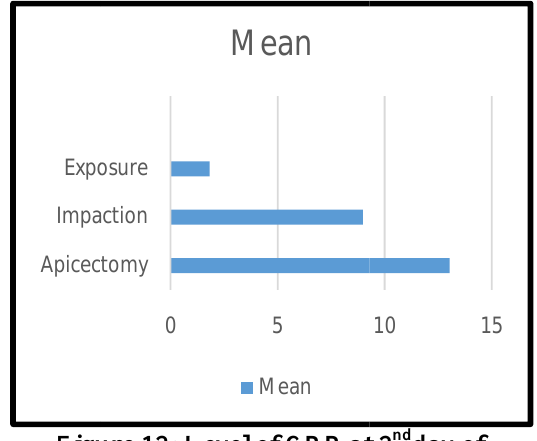
Figure 12: Level of CRP at 2 surgery